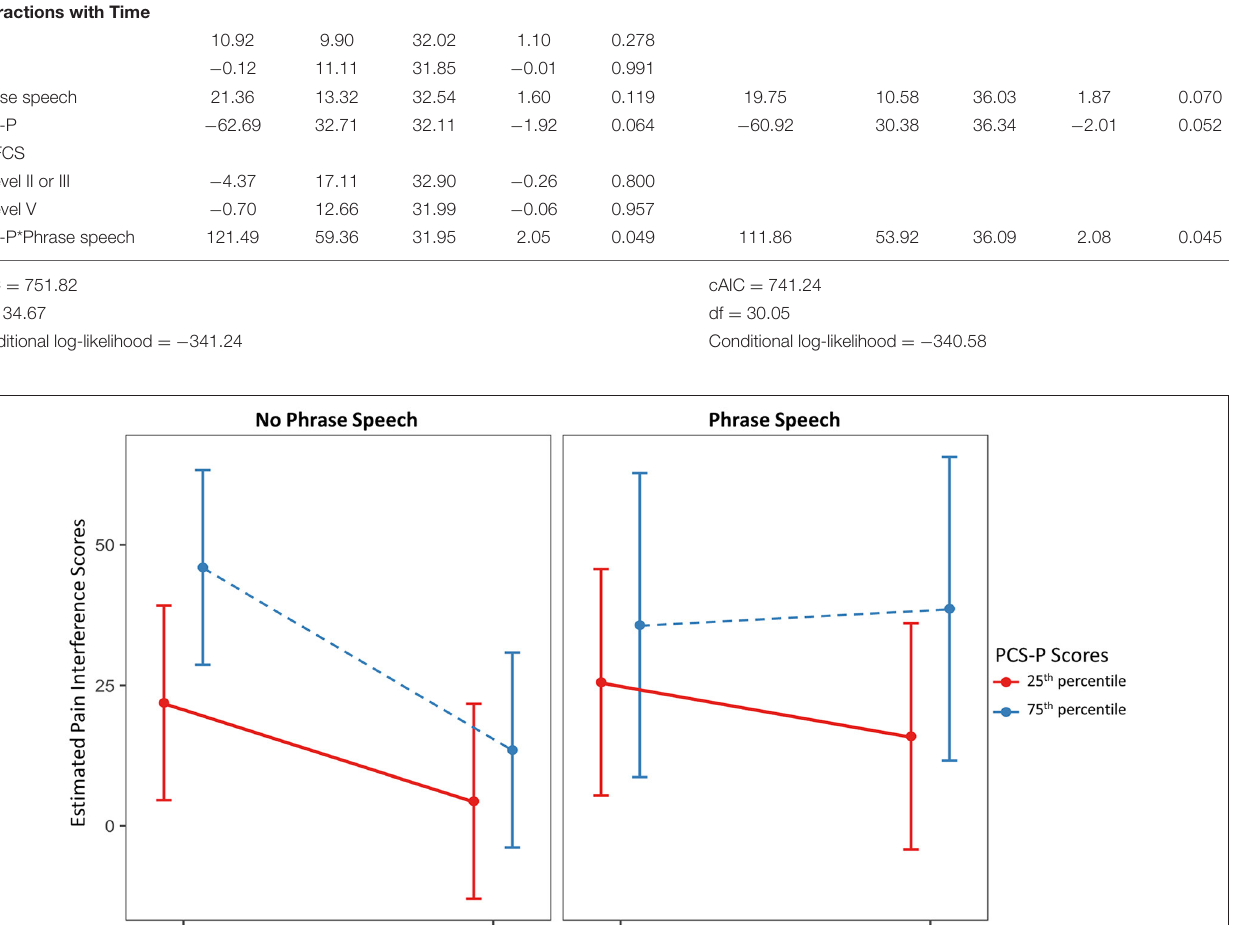
pain interference scores were wide, particularly in the group with phrase speech. Further, the findings do not provide information regarding the causality of the relationship between pain interference and PCS-P scores. In the context of chronic